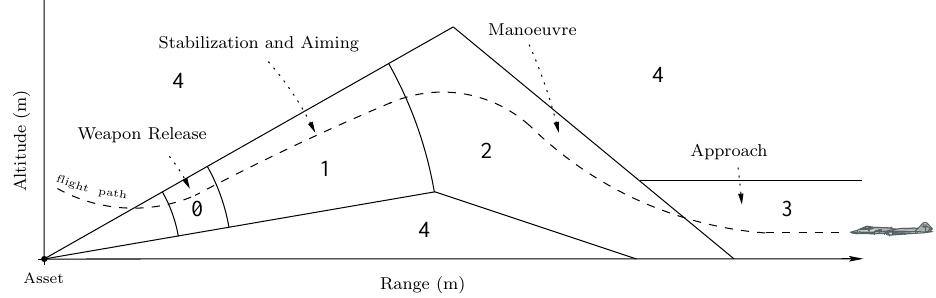
Figure 5: Weapon delivery stages S C ∗ = { 0 , 1 , 2 , 3 , 4 } associated with a hypothetical formative element combination C ∗ ∈ C